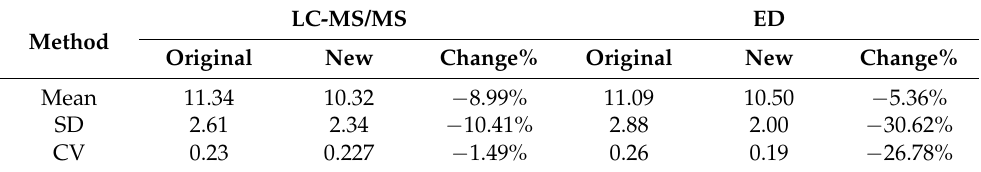
Figure 3. ( A , B top row). Comparison between FT4 values and their transformations in the reference interval scale (9, 16) of IA, with respect to LC-MS/MS and ED, using piecewise linear transformation. ( C , D middle row). FT4 values and their transformations in the reference interval scale (8, 21) of LC-MS/MS, with respect to IA and ED, using piecewise linear transformation. ( E , F bottom row). Comparison between FT4 values and their transformations in the reference interval scale (7, 23) of ED, with respect to LC-MS/MS and ED, using piecewise linear transformation. Blue represents original FT4 result, orange represents the transformed scale (from the blue line) to the scale of interest, while green represents the original untransformed results in the scale of interest. Table 6. Mean, SD and CV of FT4 transformations into the IA scale by piecewise linear